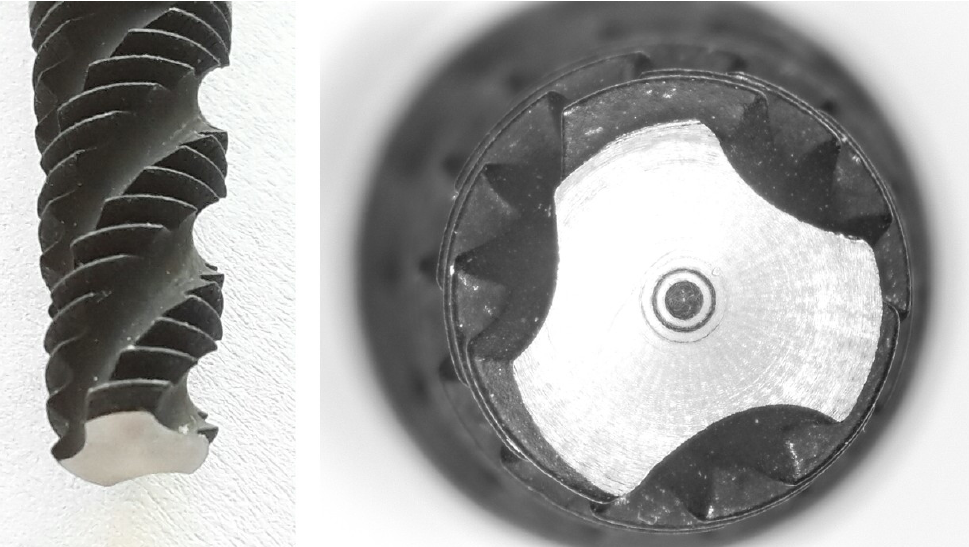
Figure 10. Example tool geometry optimized for fast process initiation and deep plunging, as used and evaluated in